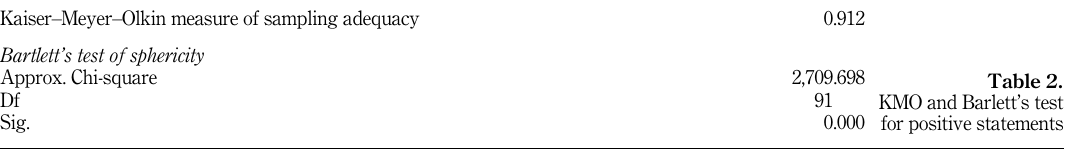
Table 2. KMO and Barlett ’ s